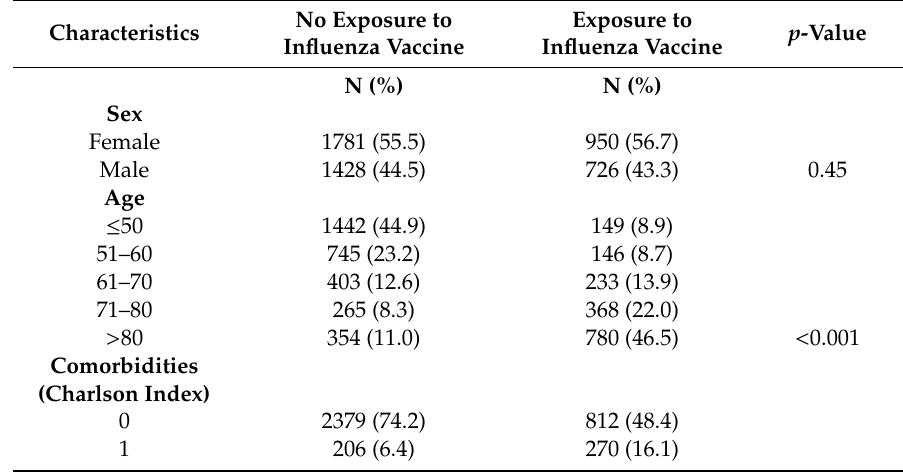
Table 3. COVID-19 patients diagnosed in the province of Reggio Emilia (Italy) since pandemic